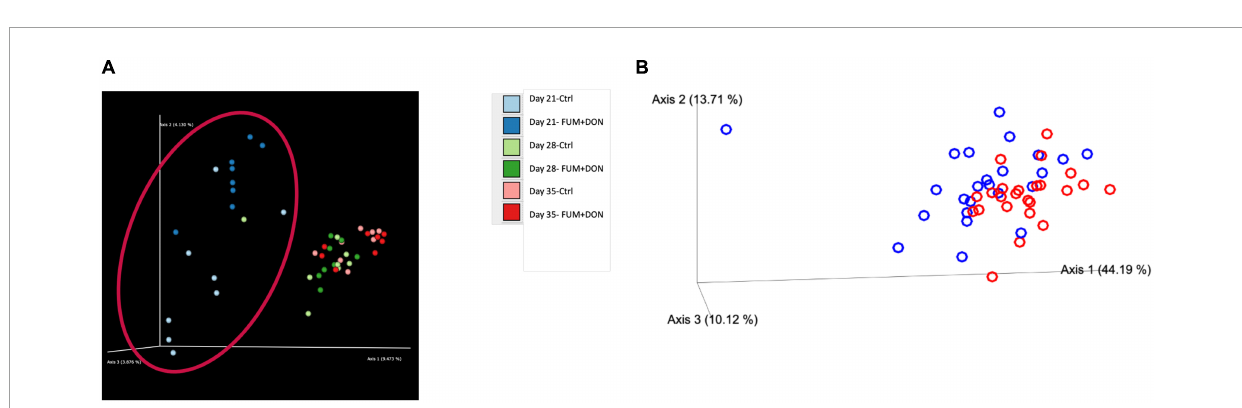
FIGURE7 Effect of subclinical fumonisins (FUM) and deoxynivalenol (DON) contamination on (A) . Beta-diversity [based on Jaccard distances and (B) ]. Principal coordinate analysis with Bray-Curtis dissimilarity of the gut microbial community structure. Broilers were fed control or mycotoxin (FUM 3 mg/kg diet + DON 4 mg/kg diet). All birds received 1 × 10 8 CFU/bird of C. perfringens on d 19 and 20. Cecal digesta was analyzed for microbiome composition using 16S rRNA sequencing at 1, 7, and 14 days post-infection. Significant differences were observed between two groups by PERMANOVA test ( P =